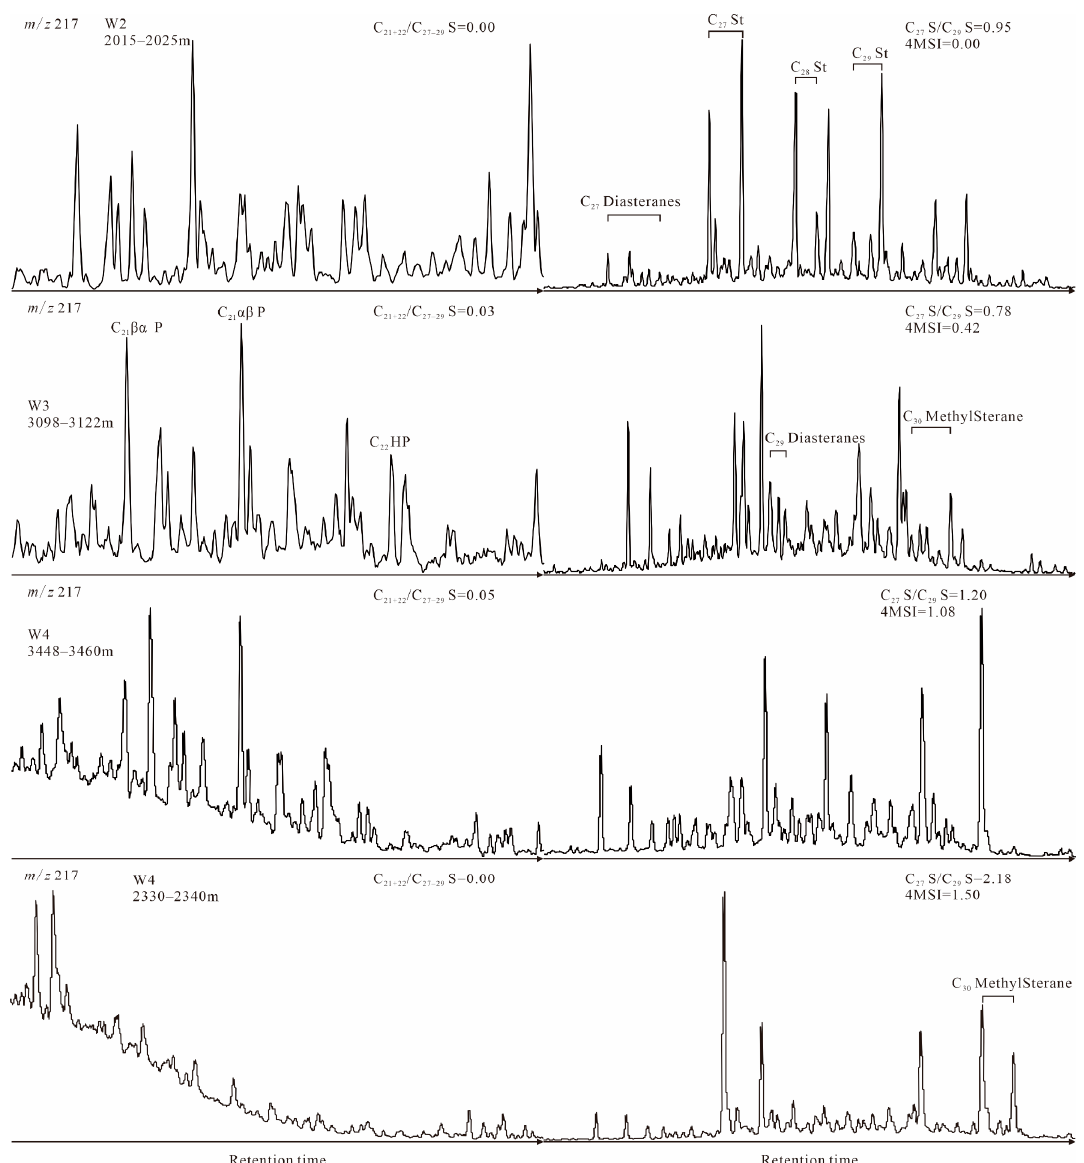
Figure 6. Selected m/z 217 mass fragmentograms for source rock samples from LS2 of the Weixinan Sag, Beibuwan Basin, showing the distribution of the sterane series.